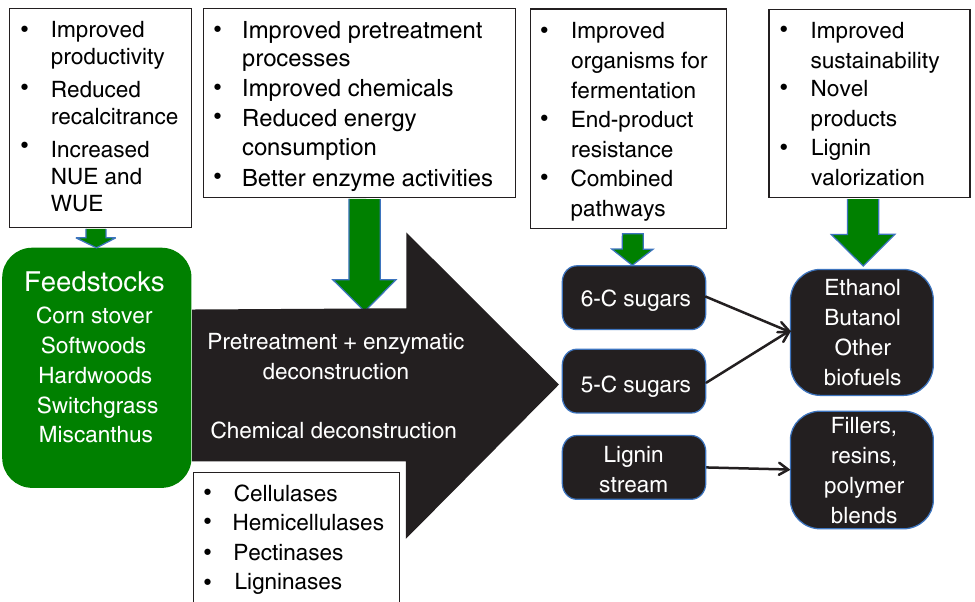
Figure 3. Production of biofuels from cellulosic feedstocks. A variety of feedstocks can be harvested, ground, and fed into unit operations that allow the tight cell wall structures to be loosened (pretreatment) for enzymatic deconstruction, or for chemical deconstruction to be accomplished. Resulting chemicals comprise five- and six-carbon sugars and lignin in a range of polymerization degrees (monomers to long polymers). Biofuels and biobased products are manufactured from these raw materials through a variety of microbial or chemical